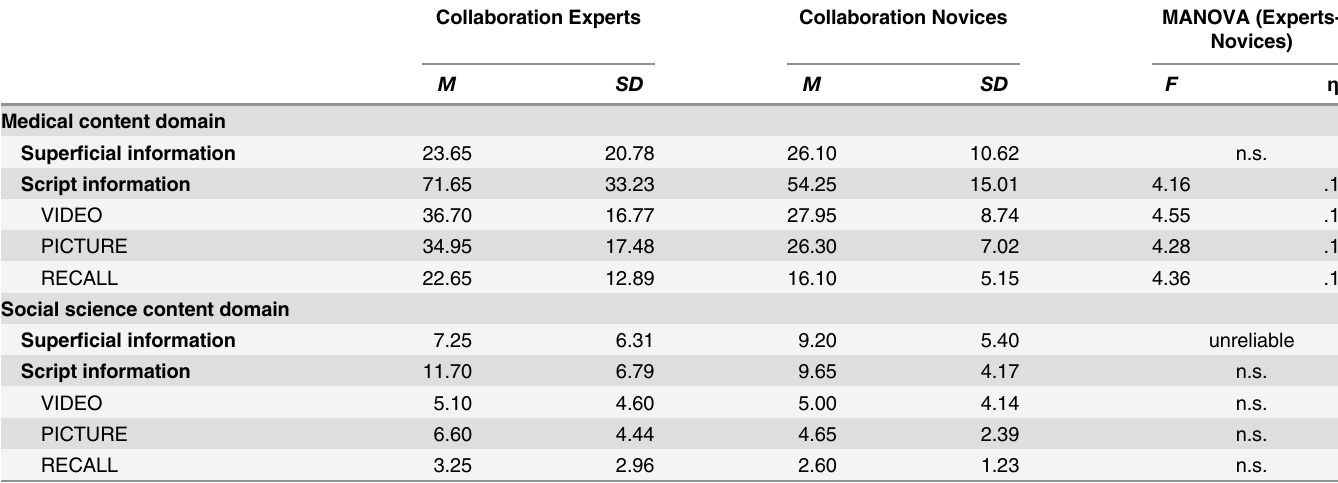
Table 5. Descriptive Statistics of Study 2. Scores represent the number of the information type stated over all the stimuli by the subsequent group. RECALL is the number of script information answered only on the recall